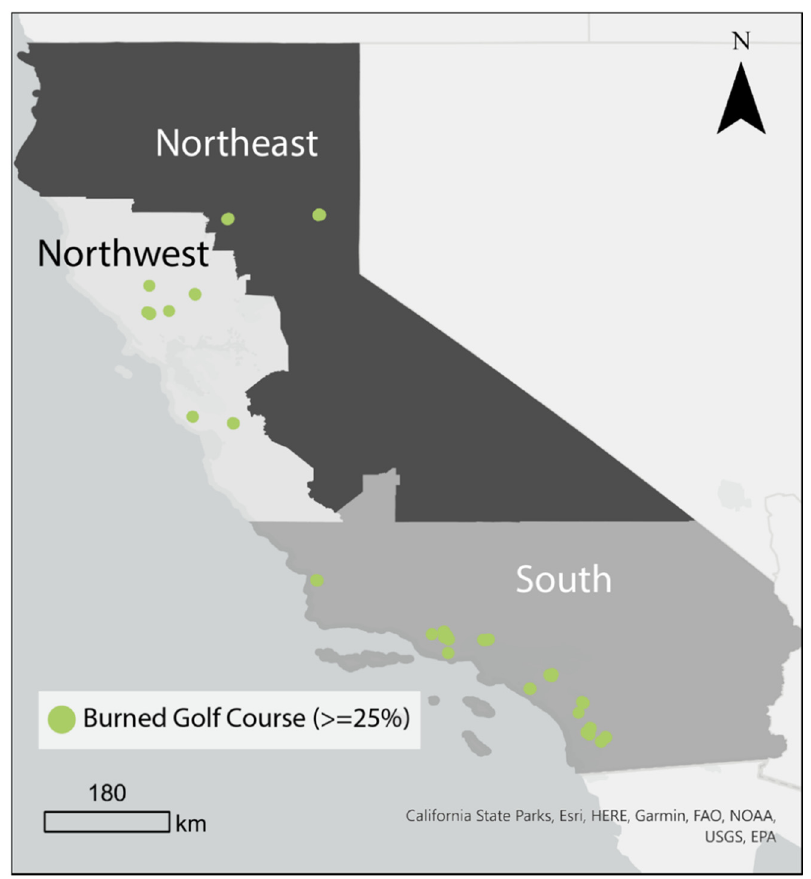
Figure 1. Map with the locations of the 29 golf courses in California that had a quarter of their area burned in a fire between 1986 and 2020.